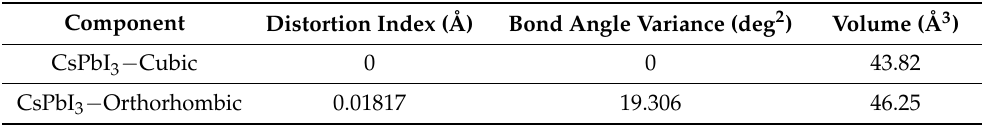
Table 4. Volume, distortion index, and bond angle variance of PbI 6 − Octahedral within the CsPbI 3